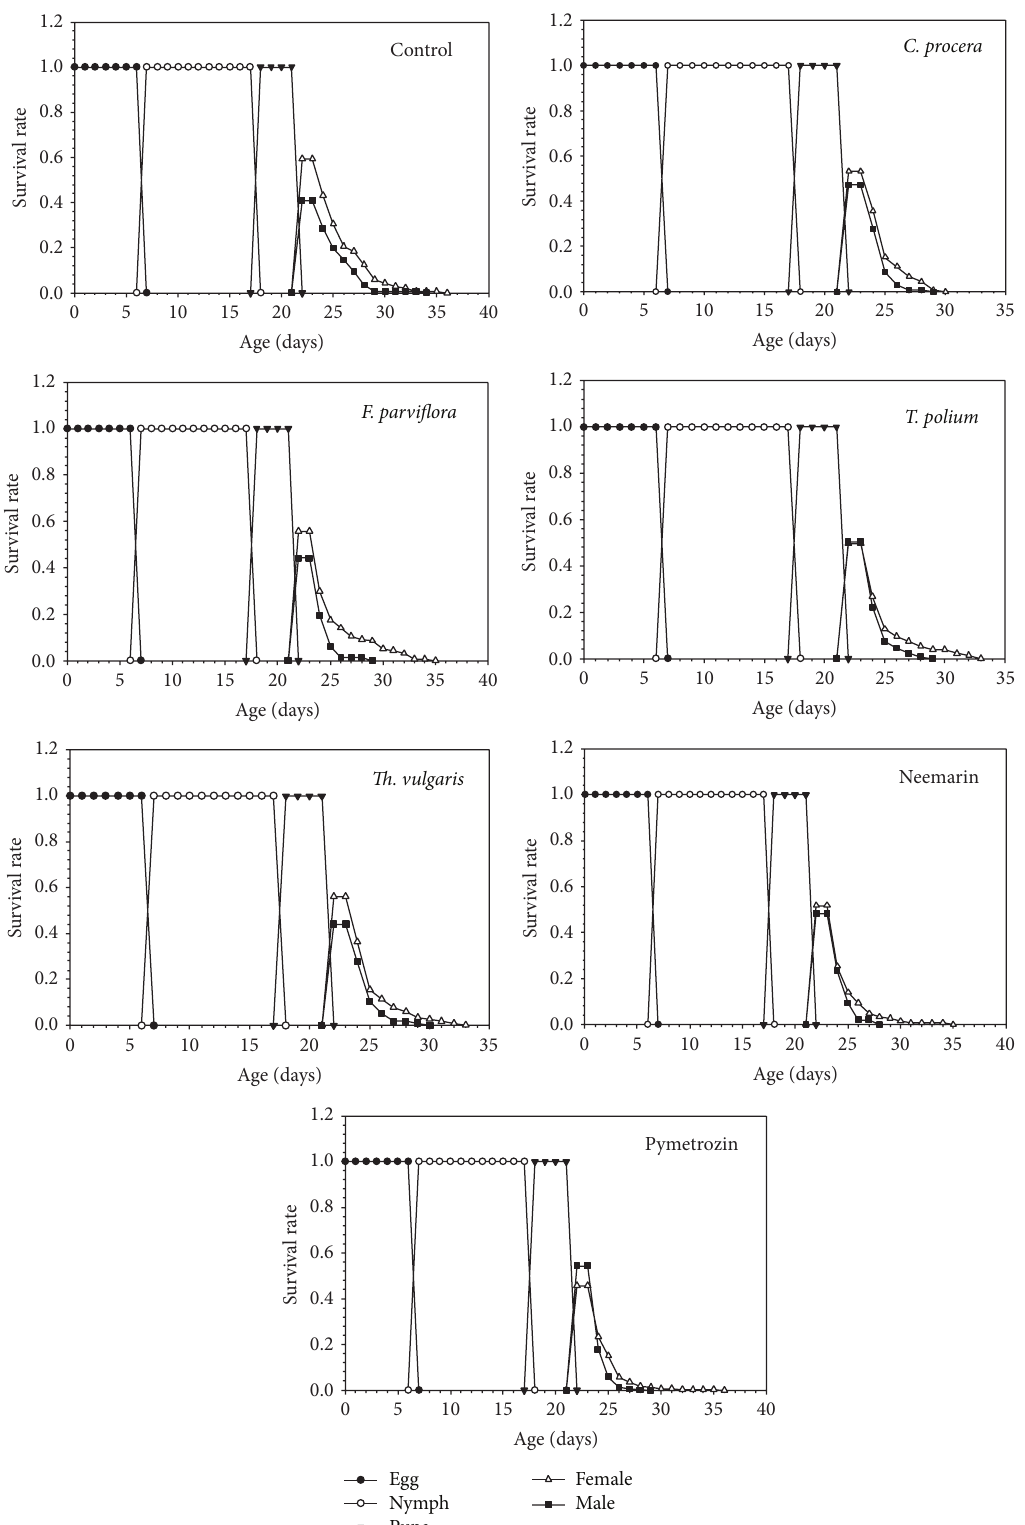
Figure 1: Effects of some synthetic and botanical insecticides on age-stage specific survival rate ( 𝑠 𝑥𝑗 ) of B.